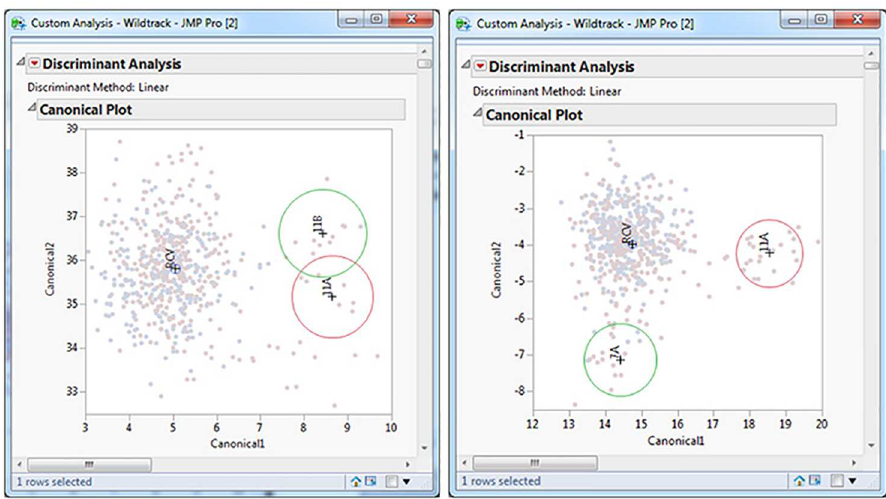
Fig 1. Pairwise comparisons. The figure shows the outcome of a pair-wisecomparisonof trails from the same individual (A) and two different individuals (B) basedon a customized model in JMP software. The classifier incorporatedinto the model is based on the presenceor absenceof overlap betweenthe ellipses. Note that the analysisis performed for each pairwisecomparisonin the presenceof a third entity, i.e. the reference centroid value